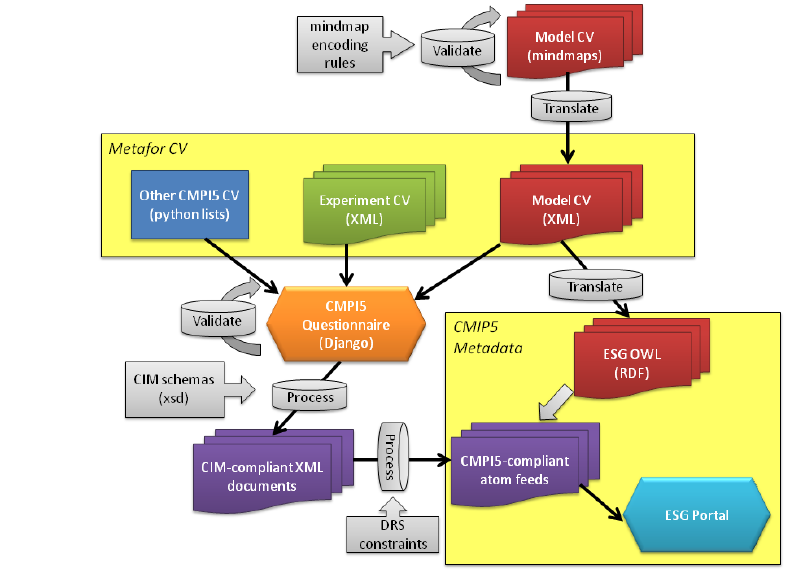
Fig. 9. Key components of the CV and information pipeline from METAFOR CV (top yellow box) to CMIP5 metadata (bottom-right yellow